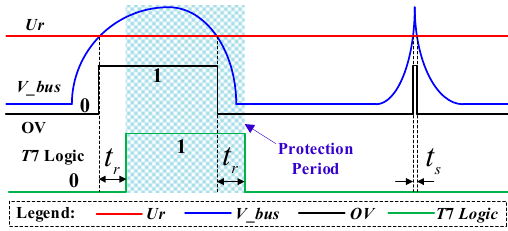
Figure 6. Bus over-voltage protection logic.